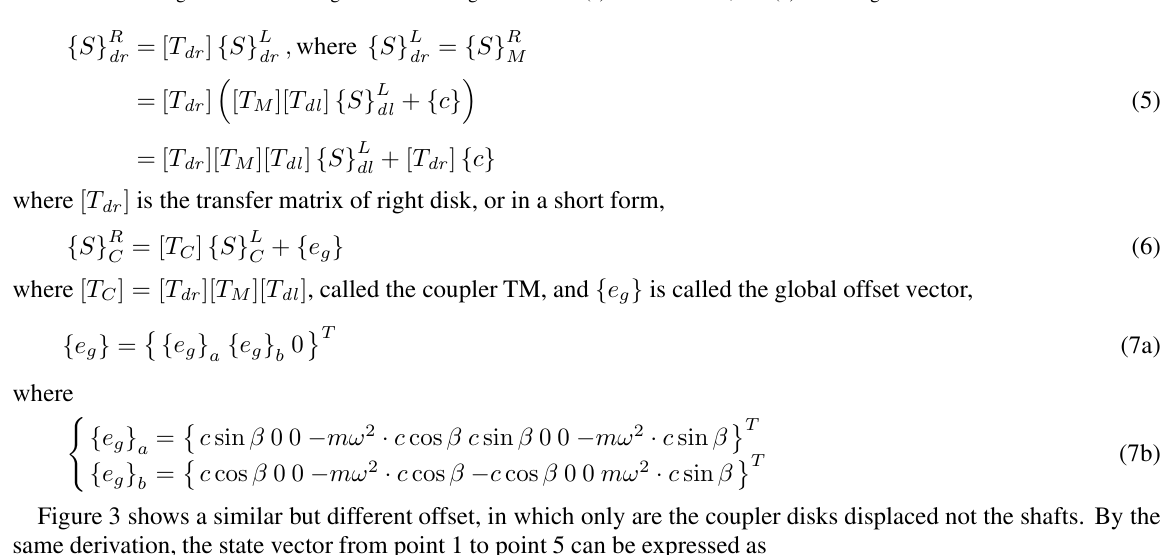
Fig. 3. Schematic diagrams of a misaligned rotor for (a) the local offset, and (b) the con fi guration of